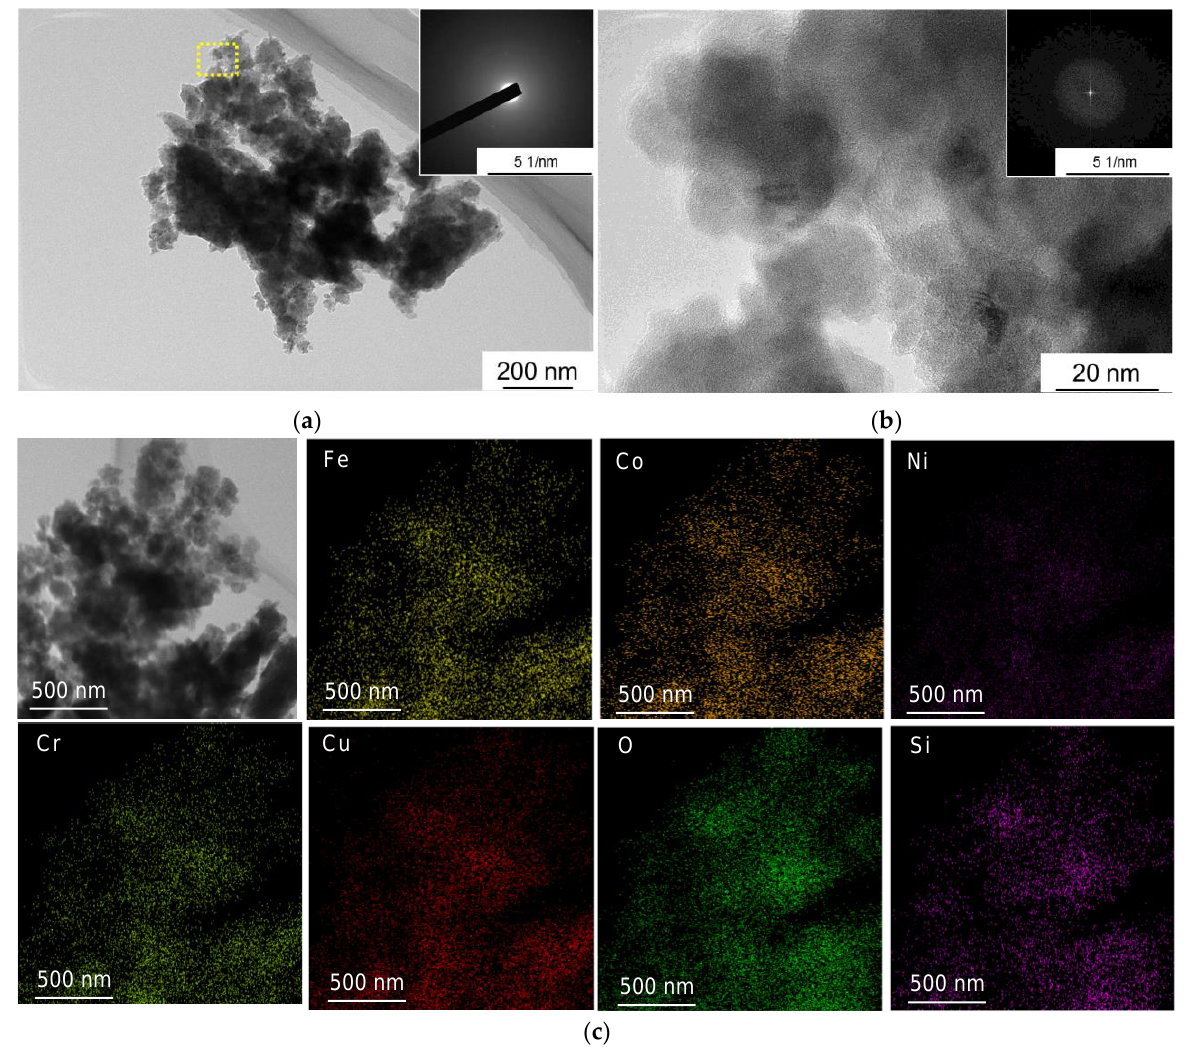
Figure 9. A TEM image of the products in the tribolayer and electron diffraction ( a ); a HR-TEM image of tribolayer particles in the area shown with a yellow rectangle ( b ); the distribution maps of elements in the agglomerate of tribolayer particles ( c ).